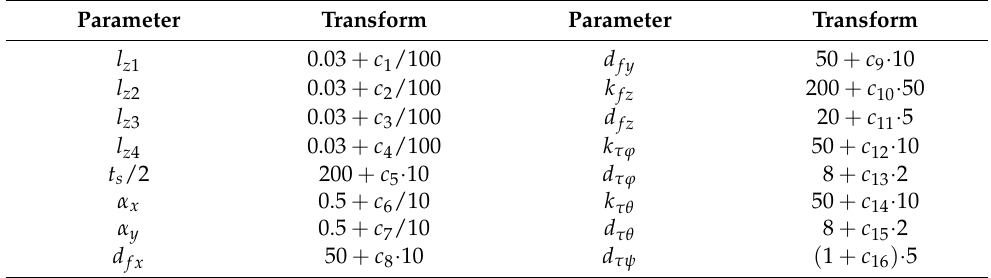
Table 1. The transform between the network action and the parameters for PDMPC. Parameter Transform Parameter Transform